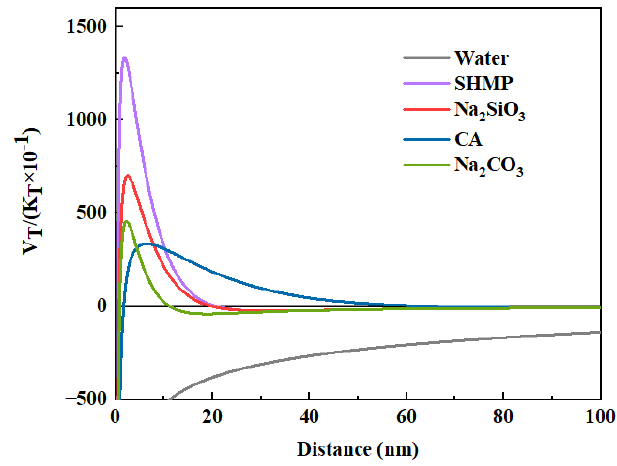
Figure 9. Relationship between total potential energies and distance between La 2 O 3 and Gd 2 O 3